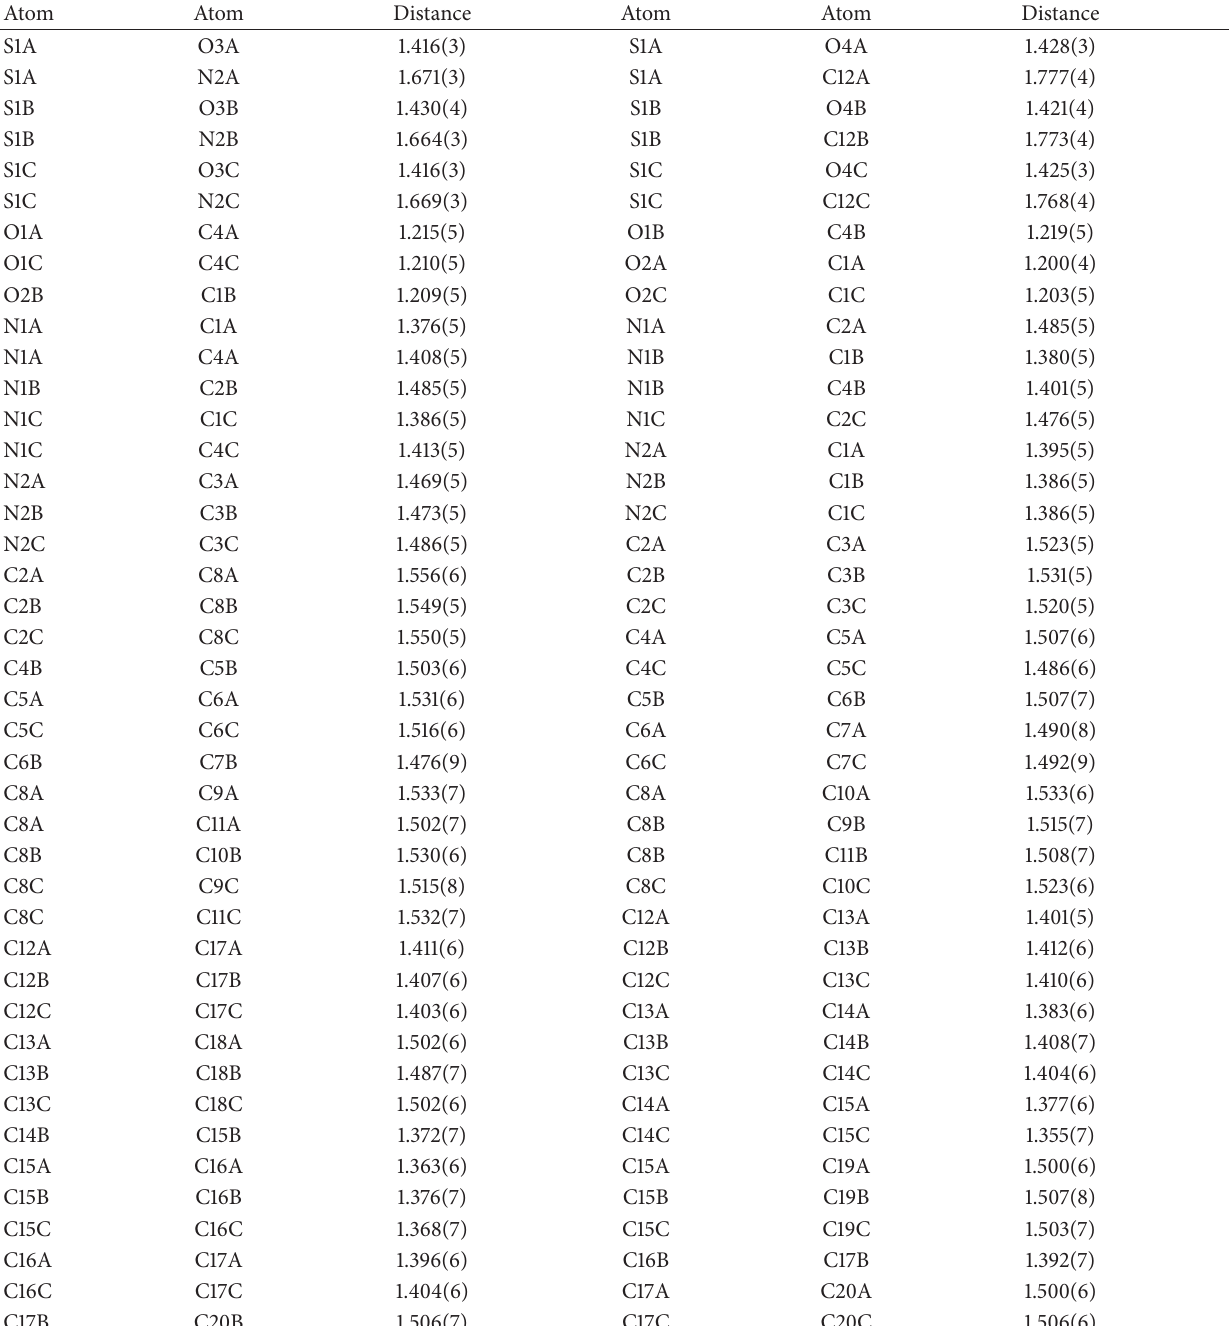
Table 2: Experimental bond lengths